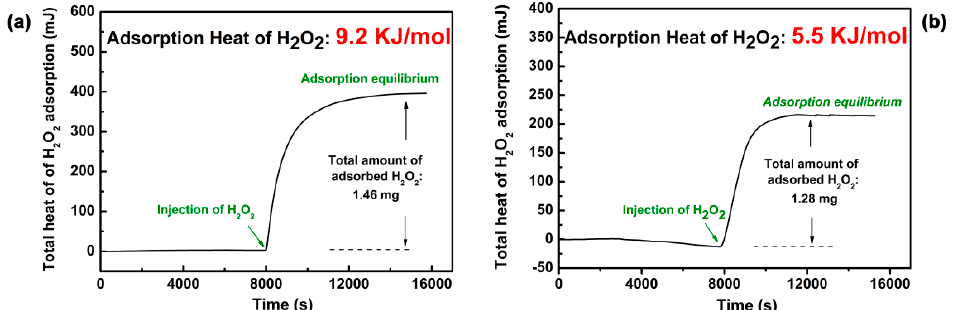
Figure 5. Adsorption heat of H 2 O 2 in the studied TiO 2 samples: ( a ) mb-TiO 2 and ( b ) C-mb-TiO 2 .